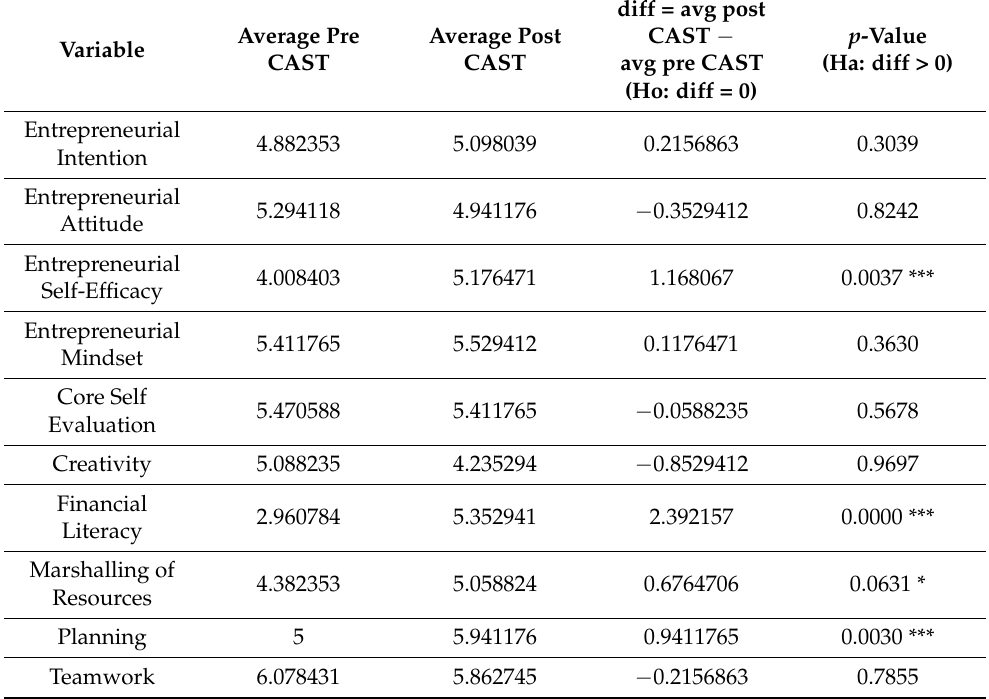
Table A7. Output of t -tests on entrepreneurial characteristics, pre- and post-course, of the students who had had no experience in practical entrepreneurship